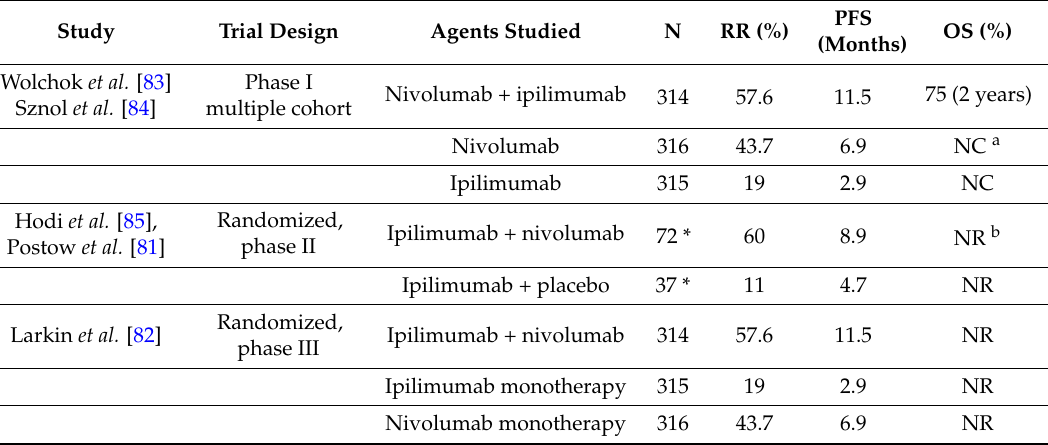
Table 2. Selected PD-1